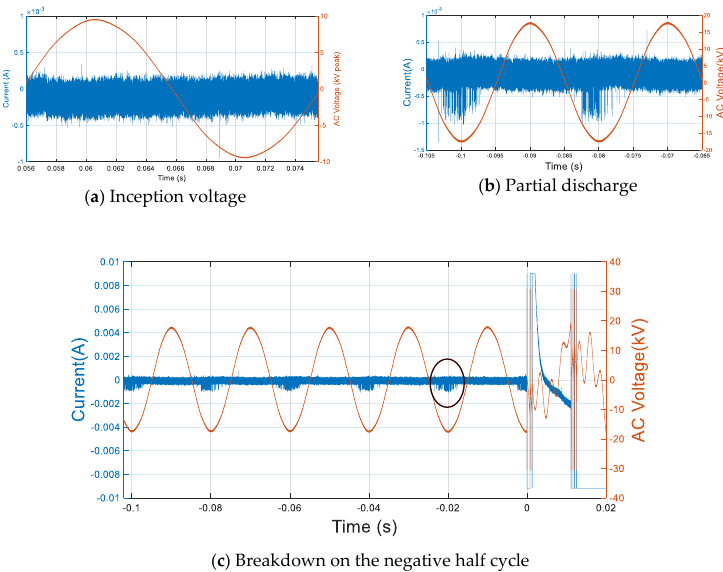
Figure 7. Voltage-current waveform for measuring inception voltage, partial discharge, and breakdown voltages (4%Novec TM 4710/96%CO 2 , P = 0.4 bar abs). Energies 2020 , 13 , x FOR PEER REVIEW